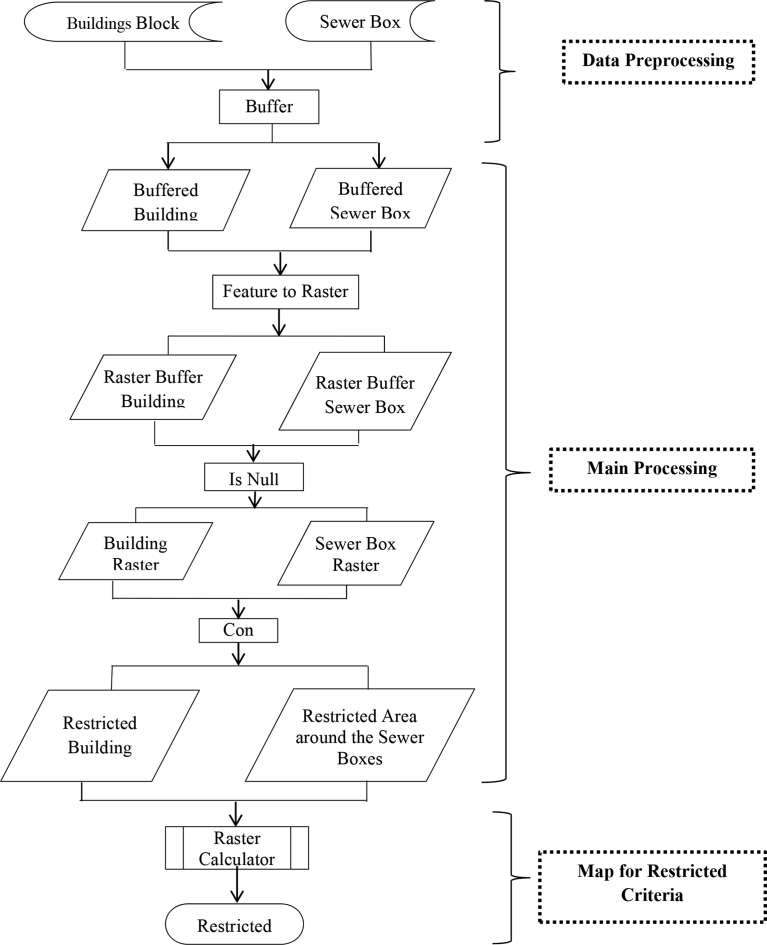
Flow chart of GIS restriction Model's structure.